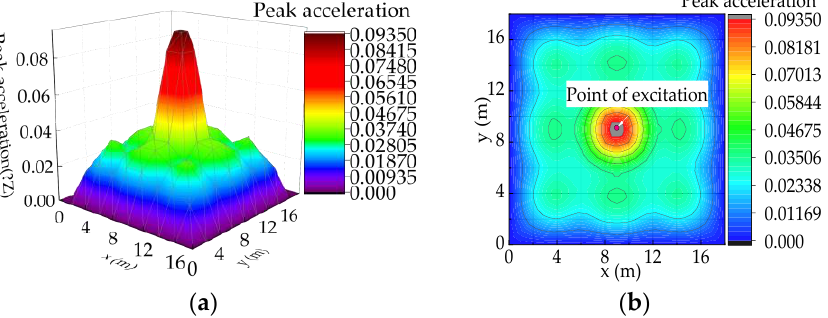
Figure 7. Acceleration distribution of point A: ( a ) peak acceleration diagram; ( b ) peak acceleration contour map.